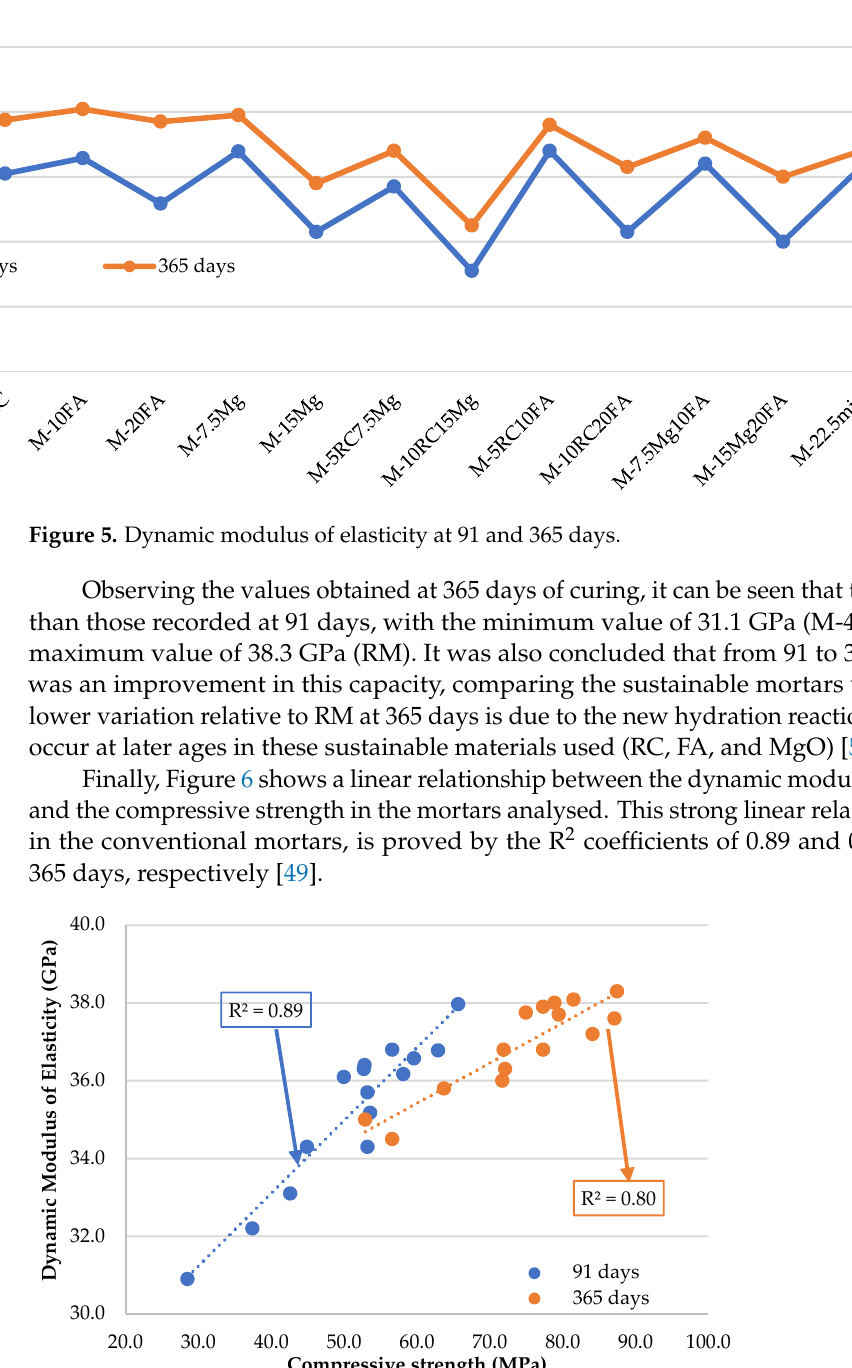
(at the same age). the same